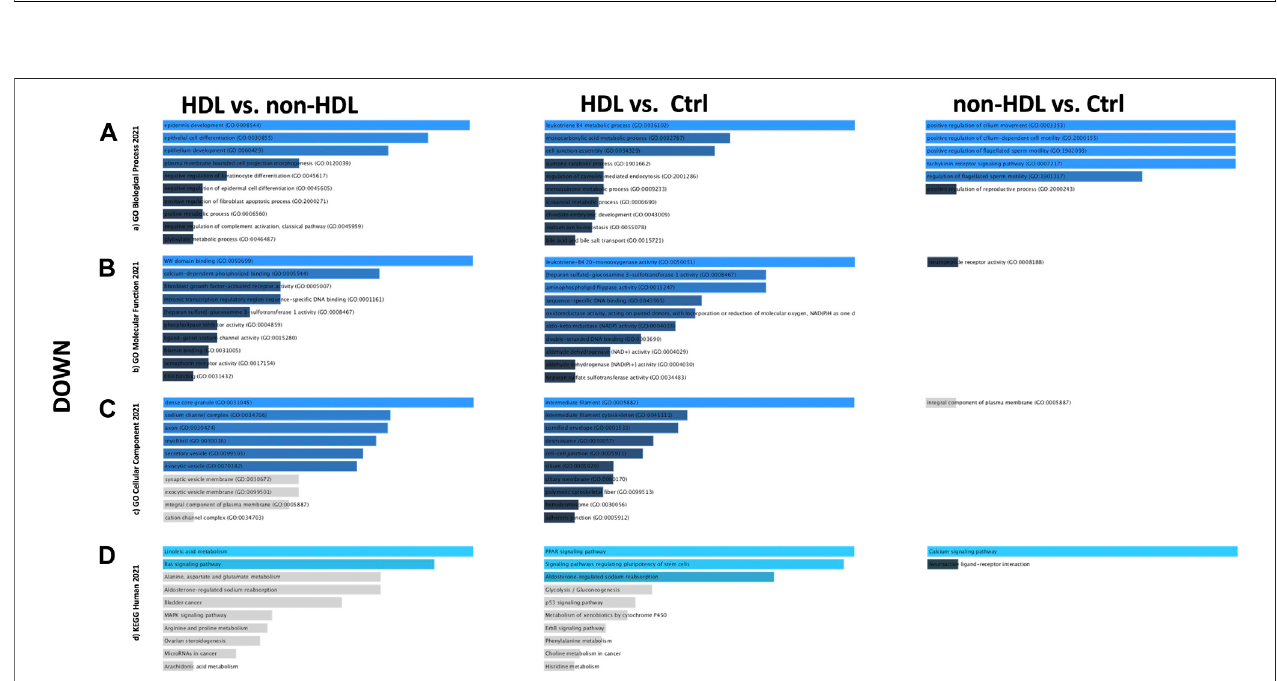
FIGURE2| GeneOntology(GO)andputativepathwaysofcommondownregulatedDEGsinBPS/ICobtainedforHLDvs.non-HLD,HLDvs.Ctrl,andnon-HLDvs. Ctrl subgroup analysis. TheGO terms were extracted from the Enrichr platform inthe form of bar graphs for each subgroup analysis, inwhich thecolor and length ofthe bars decrease as the signi fi cance decreases. Signi fi cant ( p -value < 0.05) GO terms were analyzed for (A) biological processes, (B) molecular functions, and (C) cellular components aspects, and (D) top 10 signi fi cant putative pathways predicted with the Enrichr platform obtained from the Kyoto Encyclopedia of Genes and Genomes